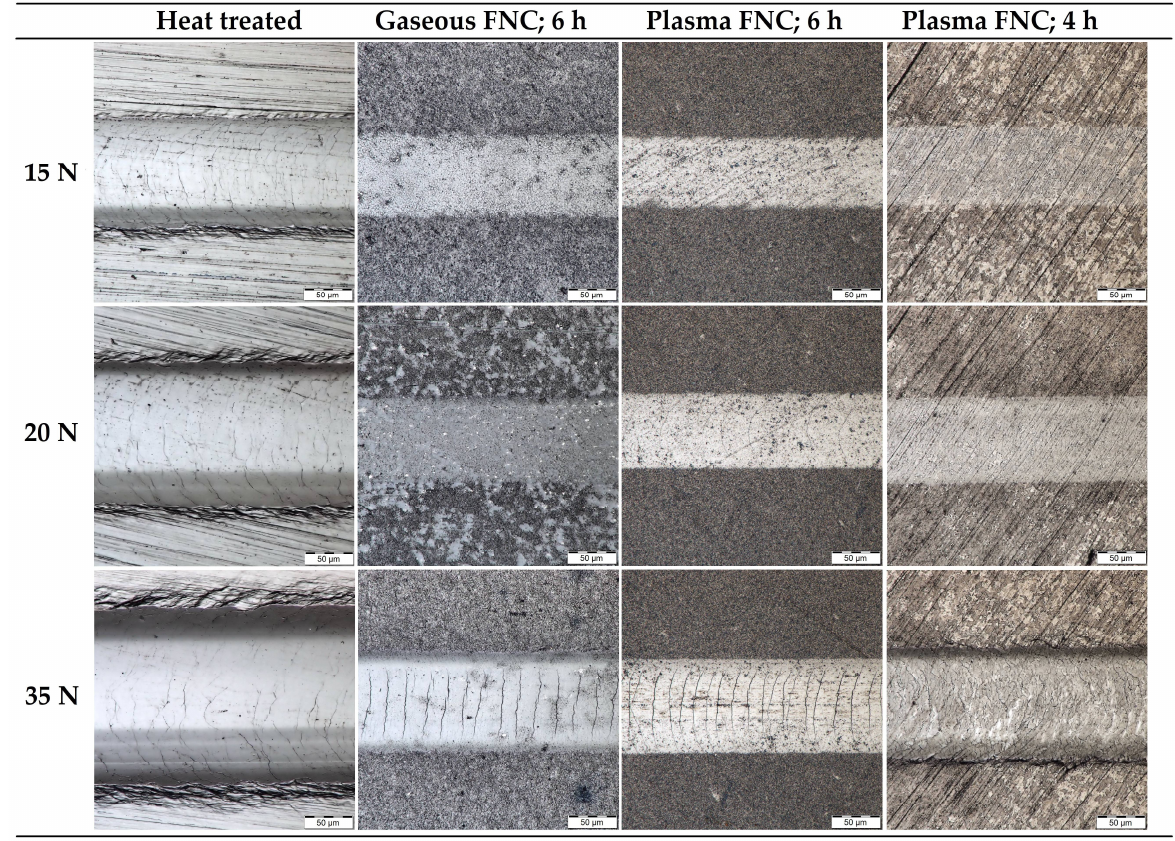
Figure 8. Images of the scratch test wear tracks. Magnification: 1000×.